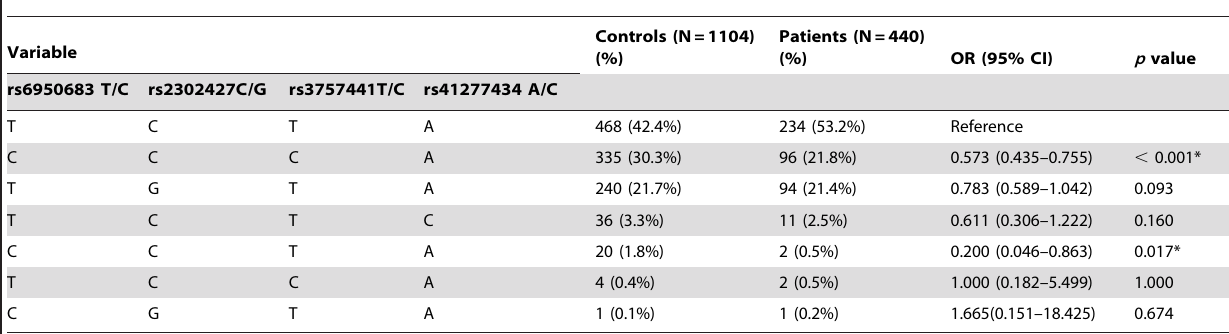
Table 6. Distribution frequency of EZH2 haplotype in control and HCC patients.